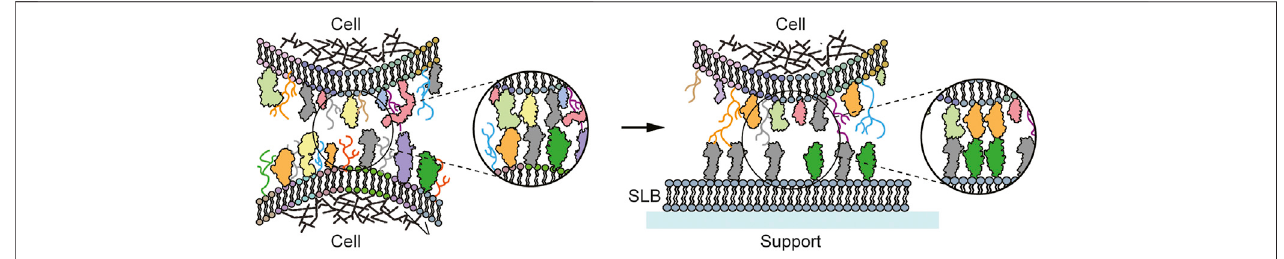
FIGURE 1 | Schematic of a cell-cell vs cell-SLB contact. Left: Cell-cell contact with the cell membrane depicting the different lipids, sugars, and proteins. Trans- interaction between the membrane proteins take place, forming the cell-cell contact. Right: Cell-SLB contact. The SLB replaces one of the contacting cells, but with a simpli fi ed composition, here containing only one type of lipid and two types of protein ligands.